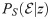
Neural data recorded from 30 mouse retinal ganglion cells stimulated by full-field illumination; see Methods
Experimental methods, for details.A. Spike trains from all 30 neurons. Note that the firing rates are strongly correlated across time. B. PS(E|z) (coloured lines) when time relative to stimulus onset is the latent variable (see text and Methods
Experimental methods). The thick black line is PS(E). C. Zipf plots for the data conditioned on time (coloured lines) and for all the data (black line). The red lines have slope −1.